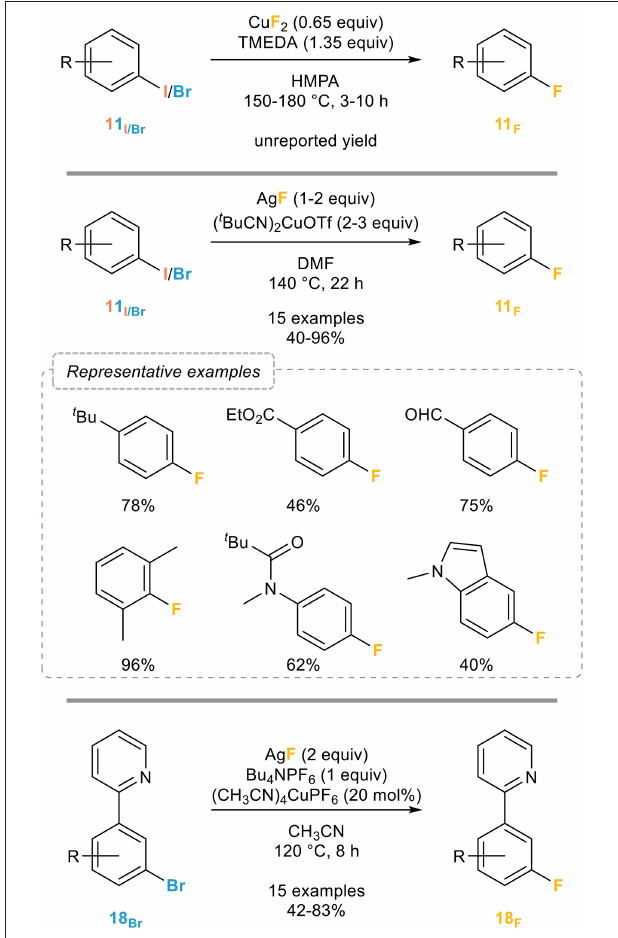
FIGURE 13 | Copper-mediated/catalyzed fluorination of aryl